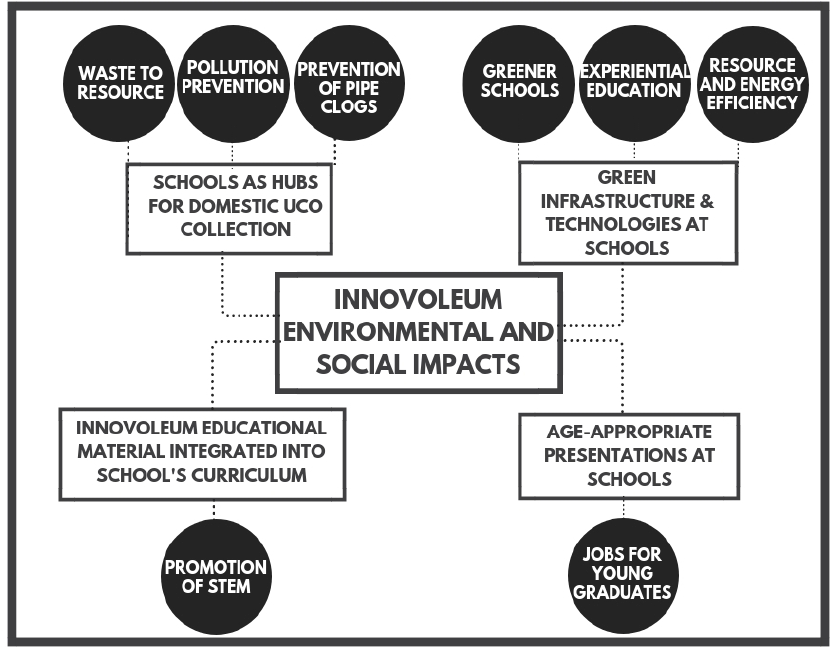
Figure 4. InnovOleum’s environmental and social impacts.